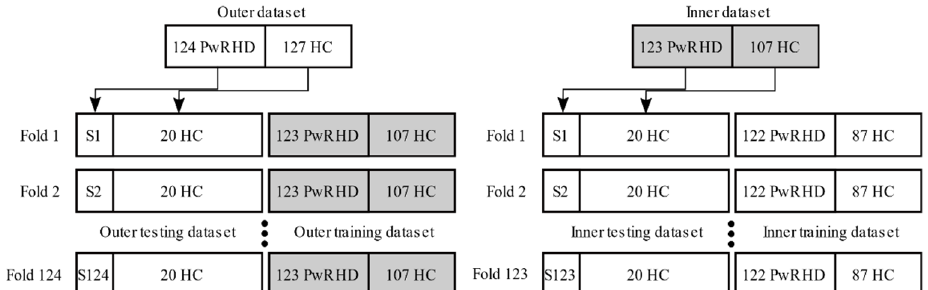
Figure 4. A visual overview of the imbalanced nested cross-validation approach. The nested approach used an outer loop to run a model evaluation criterion and an inner loop to optimize a model selection criterion. The outer and inner datasets were partitioned according to a leave-one RHD subject out approach. Given n PwRHD, the proposed partitioning results in n outer folds and n − 1 inner folds. For each outer fold, the number of HCs to reach a certain desired RHD prevalence were randomly pooled from the outer dataset, i.e., 20 HCs to evaluate for the desired RHD prevalence of 5%. Similarly, for each inner fold, the number of HCs were randomly pooled from the inner dataset to optimize the hyperparameters for a certain desired RHD prevalence. This conservative approach ensured complete separation between model selection and model evaluation.